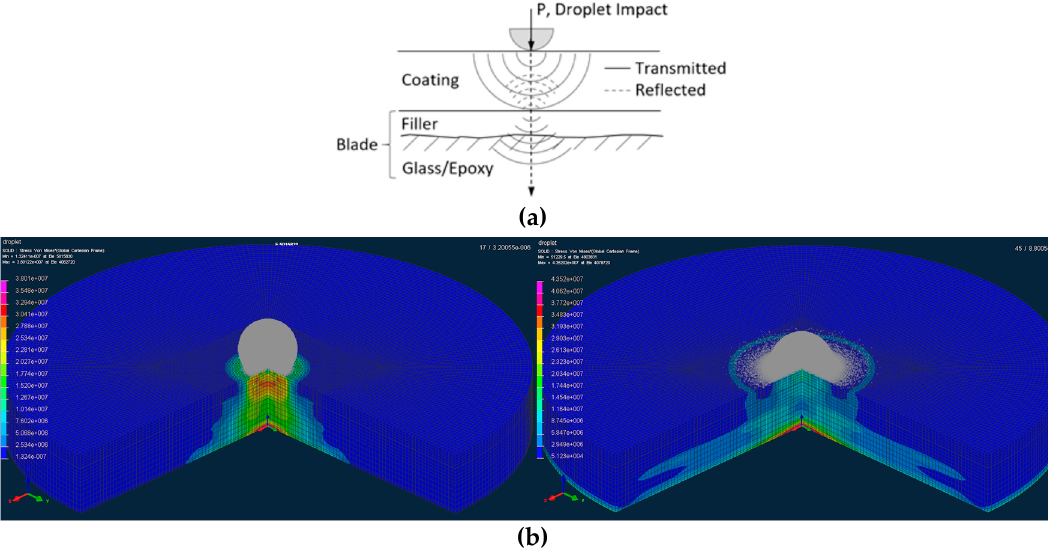
Figure 4. ( a ) Standard blade structure sketch with a filler intermediate layer showing stress wave behavior under impingement and ( b ) Liquid droplet-solid surface impact interaction depicted from numerical simulation developed by the authors.